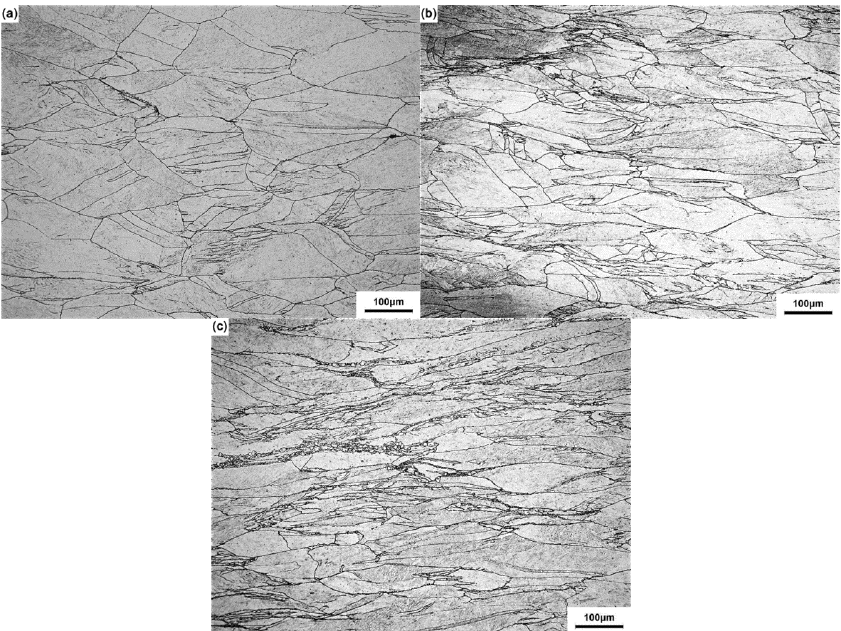
Figure 9. The microstructure of the deformed 30Cr2Ni4MoV steel to a strain of 0.7 at 850 °C and at different strain rates: ( a ) 0. 1 s −1 ; ( b ) 1 s −1 and ( c ) 10 s −1 . Domain D takes place at the temperature range of 950–1200 °C and the strain rate range of 0.03–0.5 s − 1 .